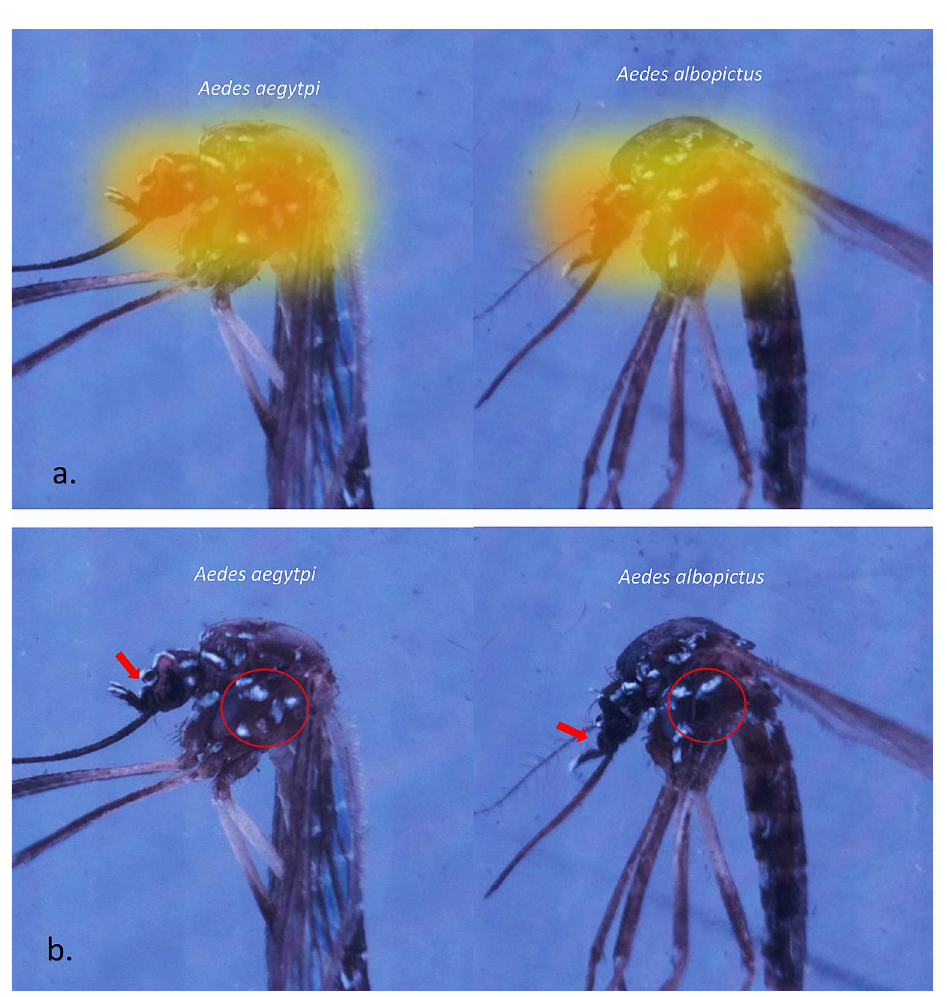
Figure 8. Feature activation on mosquito images. ( a ) Feature activation maps show most of the recognition maps focused on the head and thorax of mosquitoes. ( b ) We suggest that the morphological features used by the DCNN to distinguish between Aedes aegypti and Aedes albopictus are the mesepimeron, which shows two well- separated white-scale patches (red circles), and the pedicel, which shows white-scale patches (red